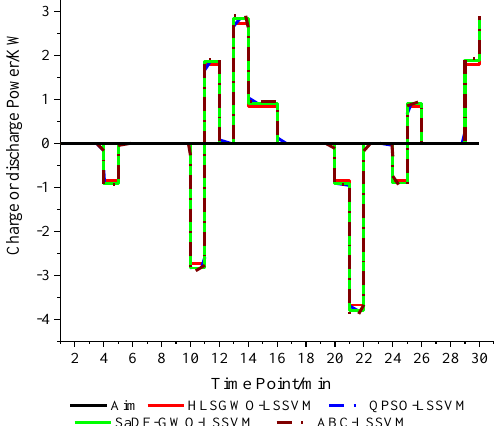
Figure 13. The charge-discharge power of HESS.